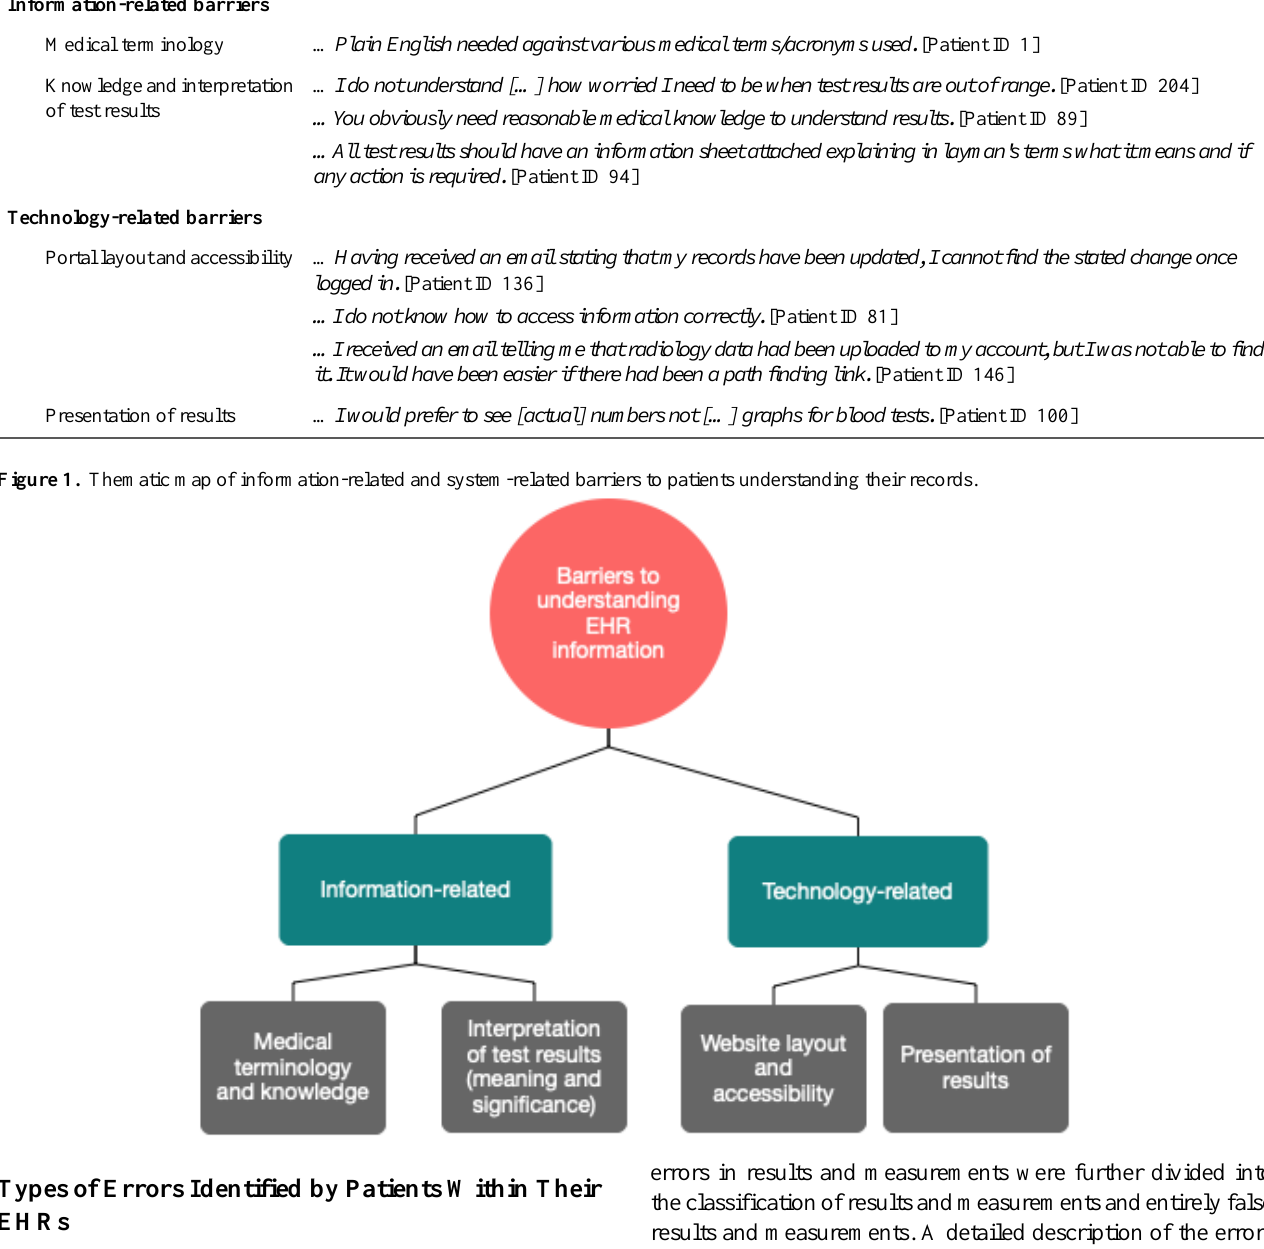
Table 2. The subthemes of incomplete information included information on appointment details and results.